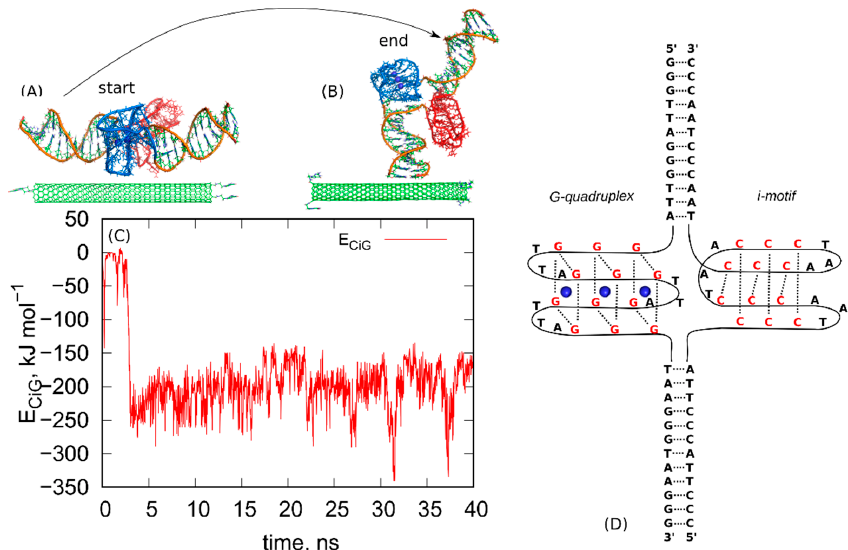
Figure 1. ( A ) The initial configuration of the system composed of (10,0) fCNT and protonated iG, ( B ) the final configuration obtained after 40 ns run in NPT ensemble. The blue parts are the G-quadruplex